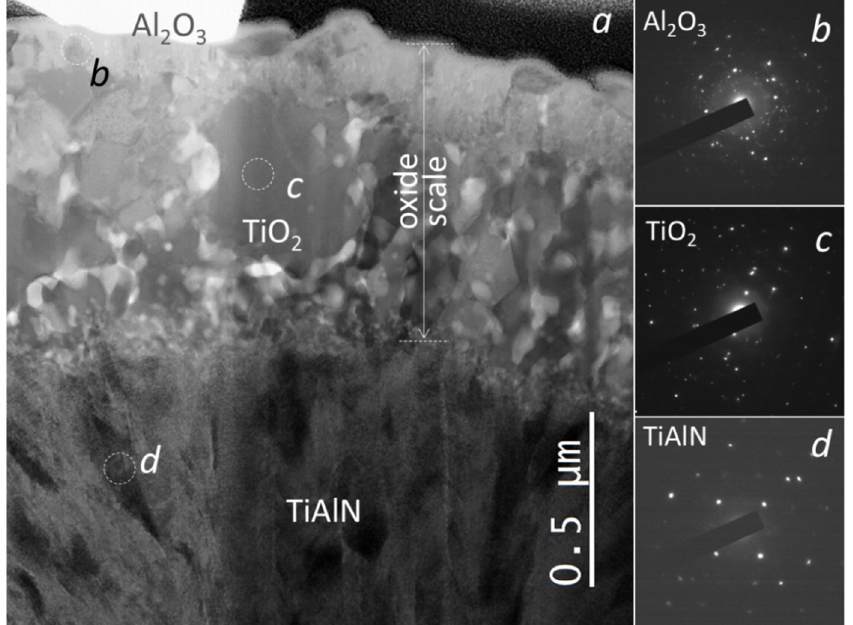
Figure 17. Bright-field STEM cross-sectional image of the oxide scale on TiAlN coating oxidized at 850 °C for 60 min ( a ) and SAED patterns of Al 2 O 3 ( b ), TiO 2 ( c ), and TiAlN ( d ) crystallites at positions marked with dashed circles.